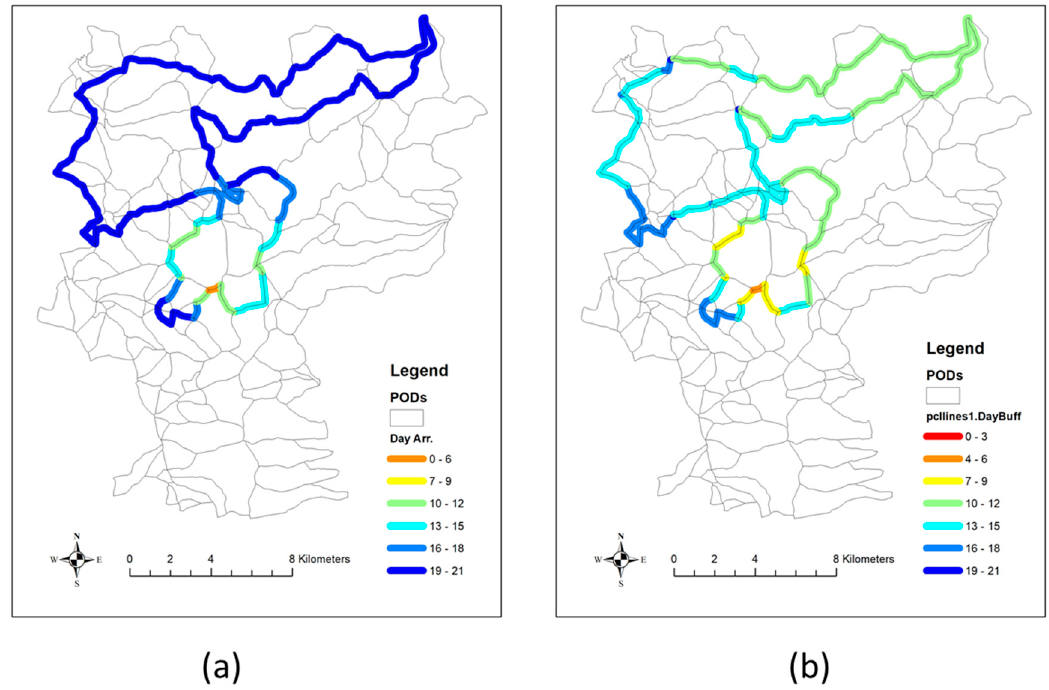
Figure 5. Mapping the optimal response strategies in Scenario C using fire arrival days ( a ) and the arrival time gap ( b ), i.e., the number of days between suppression actions and expected fire arrival.